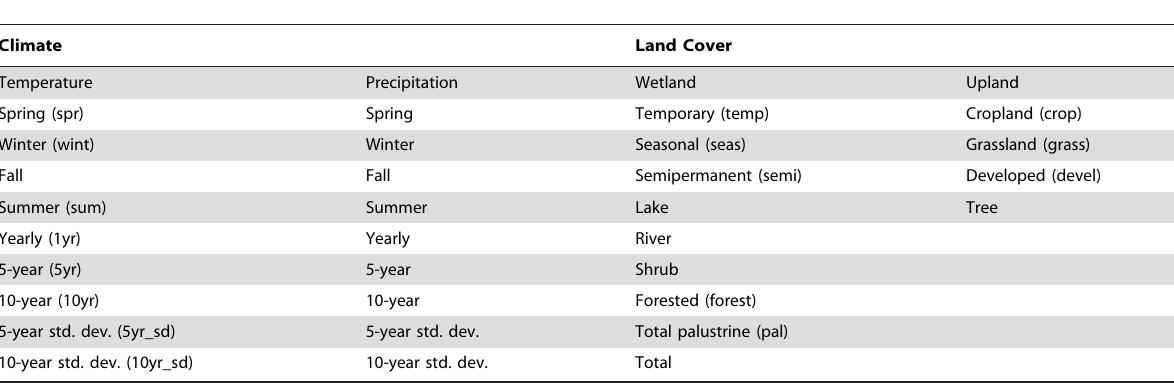
Table 1. Thirty-one climate and land cover variables used in species distribution models.